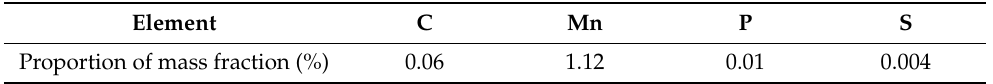
Table 1. Chemical compositions of the X70 pipeline steel and the weld. Element Proportion of mass fraction (%)